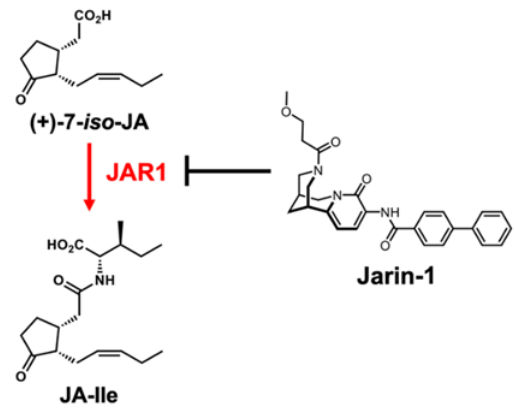
Figure 7. Jarin-1: the sole inhibitor of